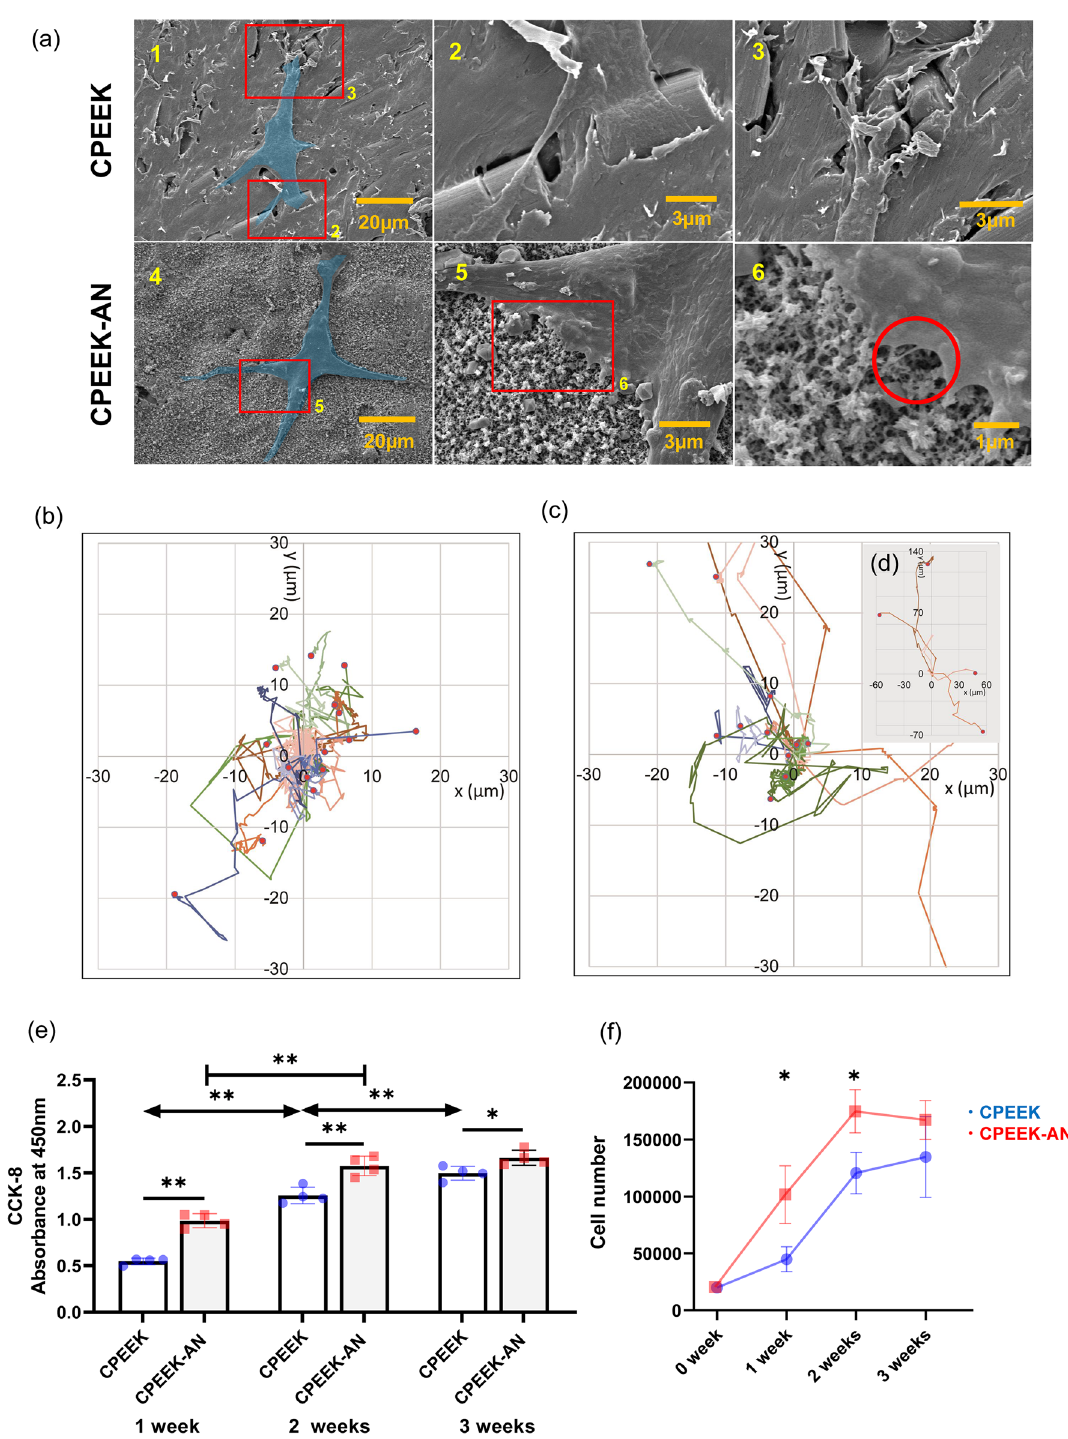
Figure 8. In vitro study1. ( a ) MC3T3-E1 cell (blue) attachment on each substrate after the 24 h incubation, observed using SEM. (a2, 3) and (a5, 6) are magnifications of (a1) and (a4), respectively. ( b ) The motion of stained cells on CPEEK, calculated with time-lapse imaging. This shows the motion with respect to the cells’ first position (X = 0, Y = 0) on the XY coordinate. The red dots indicate their final point at 24 h. ( c ) The plot depicting the XY coordinates for the motion of stained cells on CPEEK-AN. ( d ) The XY coordinates for four cells that moved beyond the XY coordinates of the plot in ( c ). ( e ) Quantification of the CCK-8 assay (absorbance at 450 nm). ( f ) The plot depicting cell numbers (manual